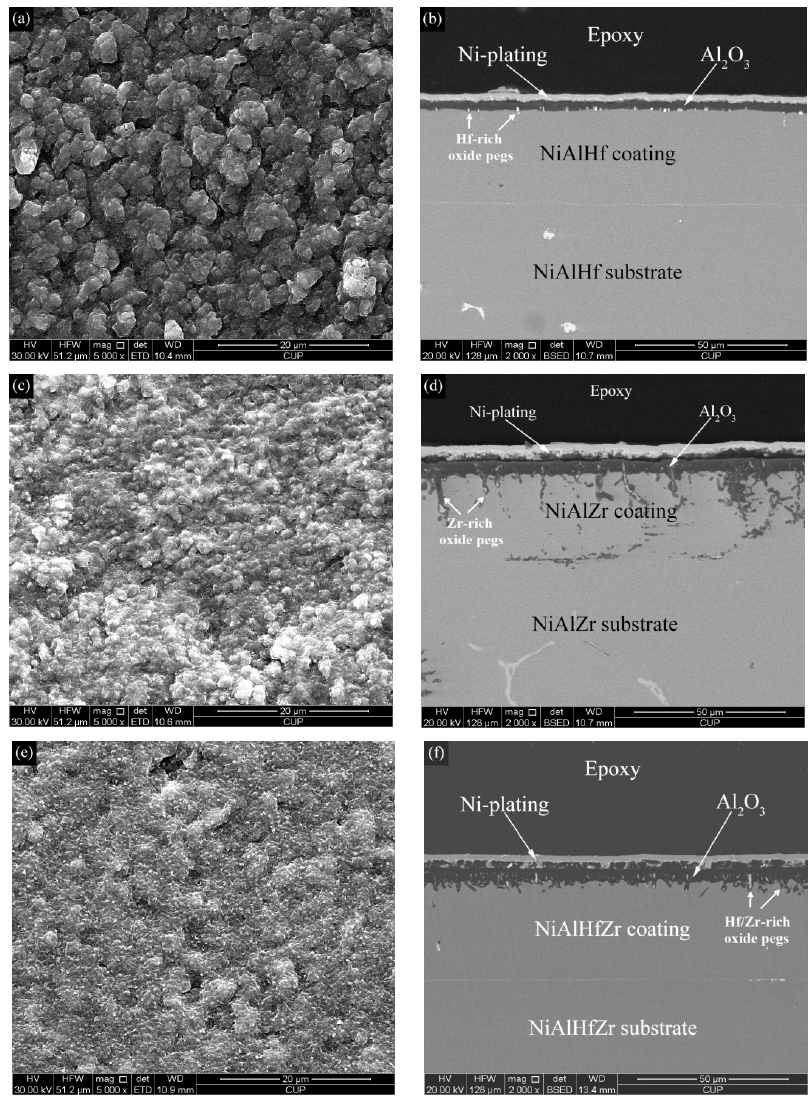
Figure 10. The surface and cross-sectional morphologies of the β -NiAl coatings on the corresponding β -NiAl substrates after 100 h cyclic oxidation at 1150 °C: ( a , b ) NiAl–Hf, ( c , d ) NiAl–Zr, ( e , f ) NiAl–Hf–Zr. As it is reported that there is a reversible diffusionless transformation from a B2 ( β ) cubic